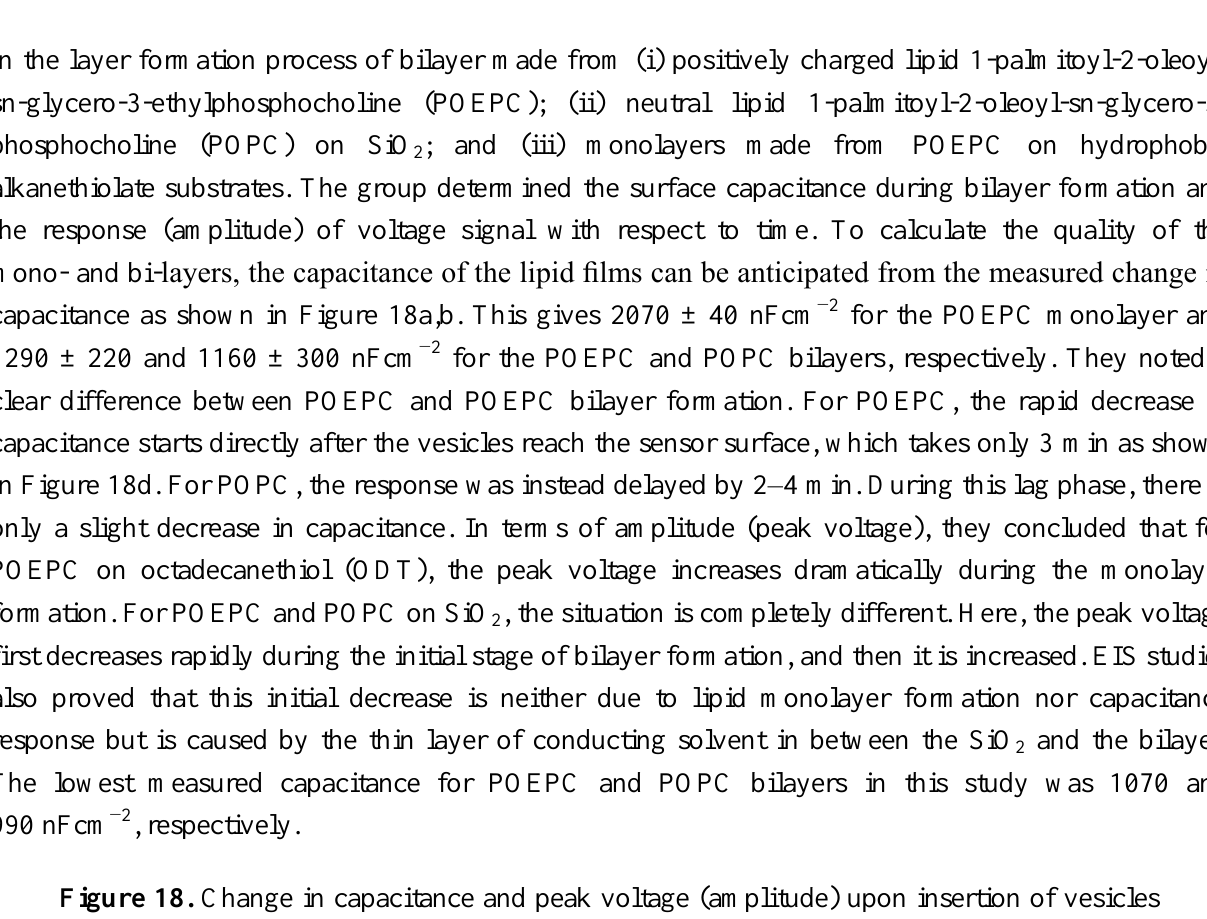
Figure 18. Change in capacitance and peak voltage (amplitude) upon insertion of